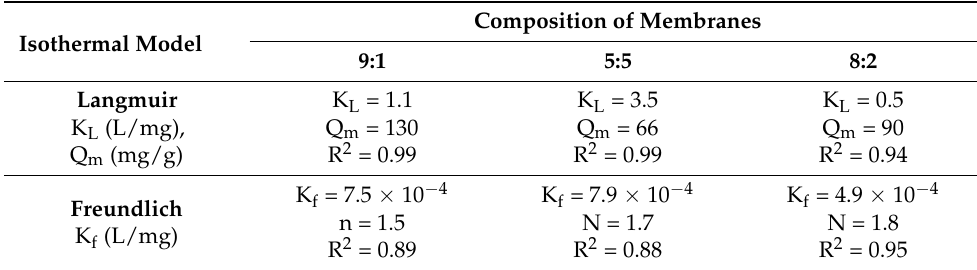
Table 2. Parameters for Langmuir and Freundlich models for the adsorption of Cu 2+ ions by the Ch-NH 2 /P(DMAM-co-GMA) membranes with different contents of chitosan hydrochloride. Isothermal Model